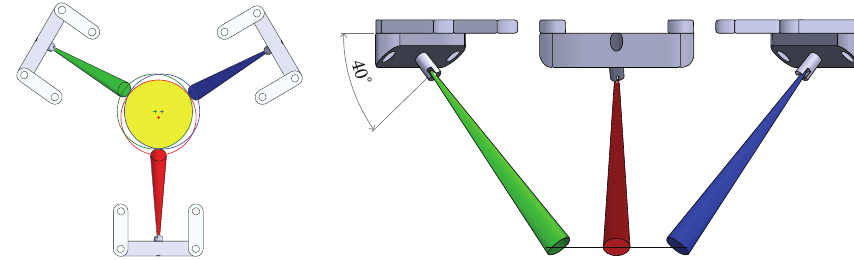
Figure 8: Simulation of projection plane with the couple link tilted at 40 degrees.